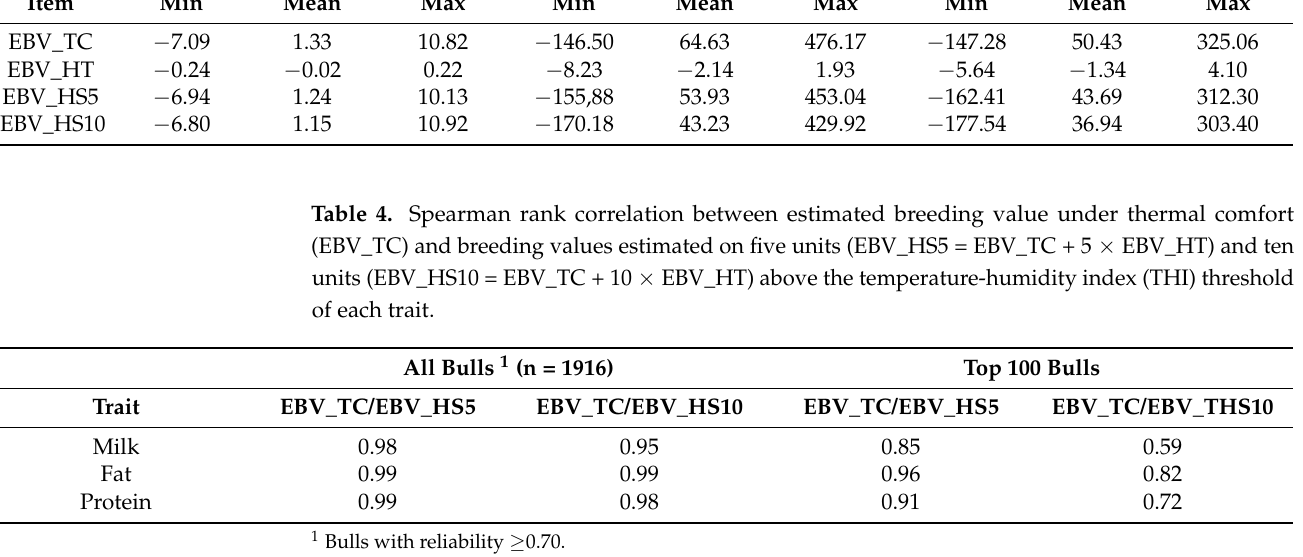
Fat Yield (g) Protein Yield (g)